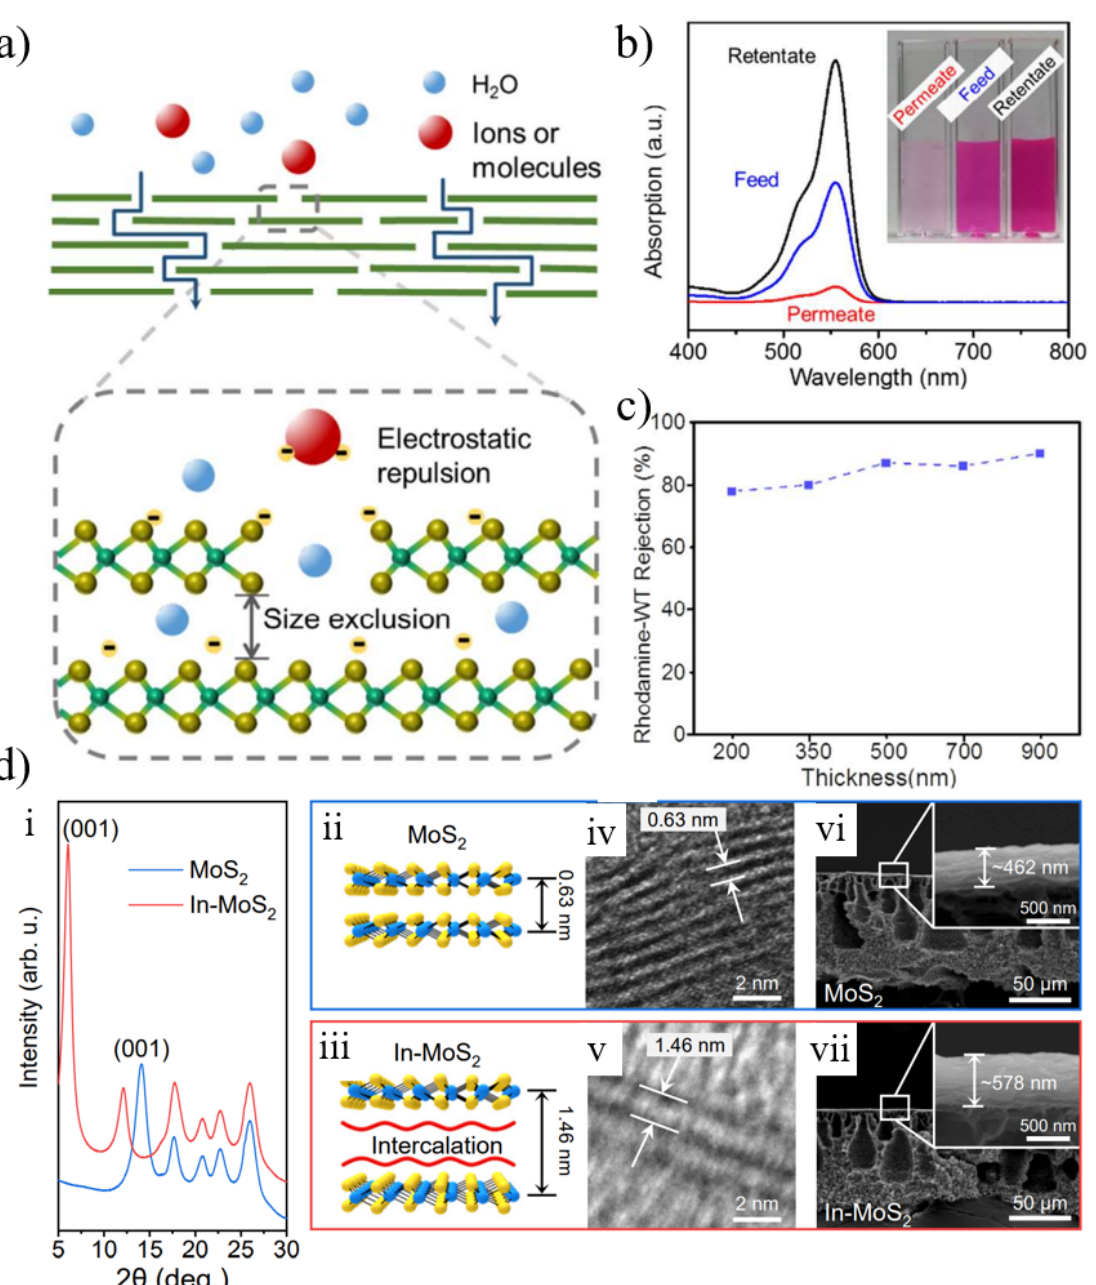
Figure 10. ( a ) The proposed mechanisms of MoS 2 membranes include both size exclusion and elec- trostatic repulsion. ( b ) The concentrations of organic dye (rhodamine-WT) in permeate, feed, and retentate, as evidenced by the absorption spectra. ( c ) Dependency of organic dye rejection on MoS 2 membrane thickness. ( d ) ( i ) XRD patterns of pristine and intercalated MoS 2 membranes. ( ii , iii ) Sche- matic illustration. ( iv , v ) TEM image. ( vi , vii ) SEM cross-section images of pristine and intercalated MoS 2 membranes. Reprinted with permission from [135,136]. Copyright (2017) Published by Amer- ican Chemical Society. Copyright (2020) Published by American Chemical Society.